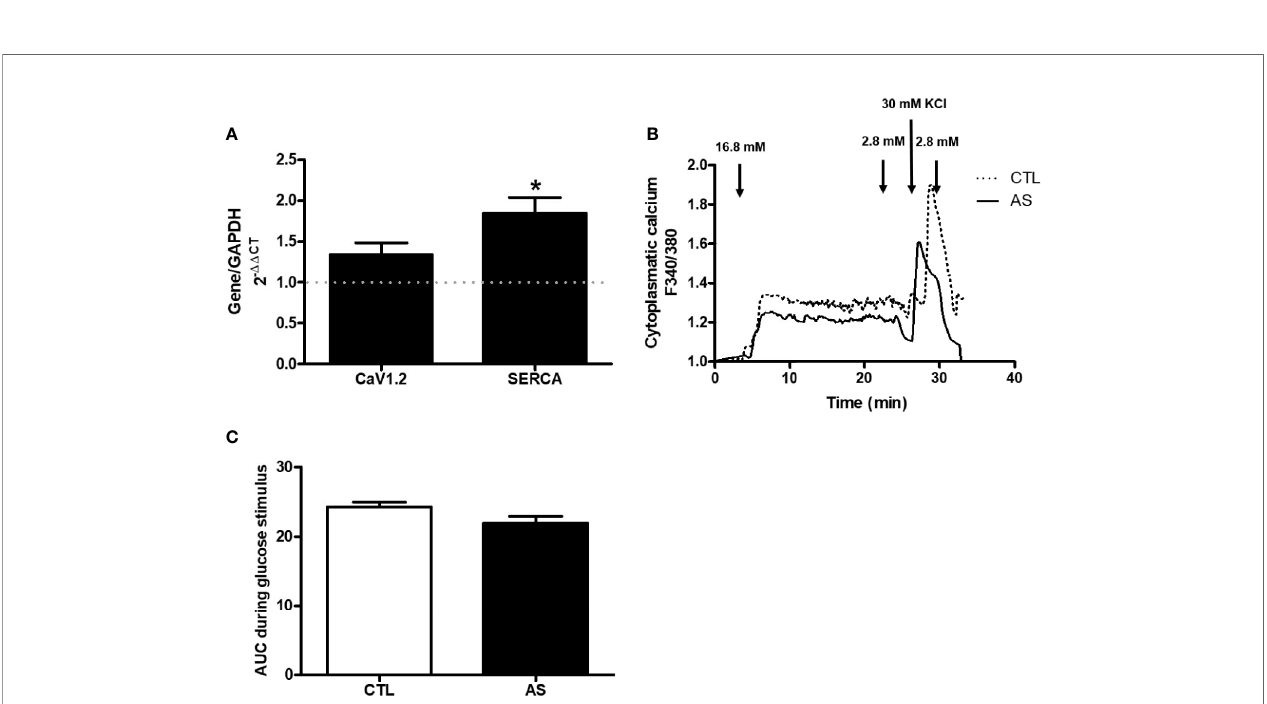
FIGURE 4 | ARHGAP21 knockdown effects on calcium channels expression and on the glucose-induced calcium dynamics of pancreatic islets. Adult mice received intraperitoneal administrations of antisense anti-ARHGAP21 for three consecutive days and pancreatic islets were isolated 24 h after the last administration. (A) CaV1.2 and SERCA gene expression related to the CTL (dash line) (B) Cytoplasmic calcium after incubation with 16.8 mM glucose or 30 mM KCl. (C) AUC of the cytoplasmic calcium during the glucose stimulus. n = 6 – 8 for CaV1.2 and SERCA expression and n = 4 for cytoplasmic calcium. Data are presented as the mean ± SEM. *P ≤ 0.05 vs CTL. CTL, control mice; AS, mice that received intraperitoneal injections with antisense anti-ARHGAP21; AUC, area under the